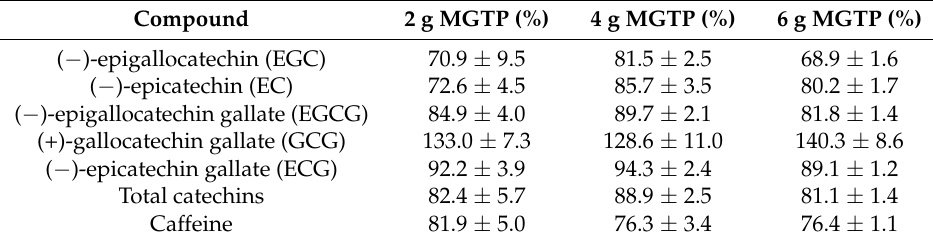
Figure 2. Amount of catechins in dough and shortbread enriched with 3 levels of MGTP (2, 4, 6 g 100 g −1 of flour): ( a ) EGC, ( b ) EC, ( c ) EGCG, ( d ) GCG, ( e ) ECG, ( f ) total catechins, and ( g ) caffeine. Results are expressed as mg per biscuit. * indicates a significant difference ( p < 0.05) before and after baking. The error bars represent the SEM (standard error of the mean) ( n = 12 biscuits). Table 1. Percentage retention of catechins and caffeine in MGTP (Matcha green tea powder)-enriched shortbread biscuits after baking as a proportion of initial content in the dough.